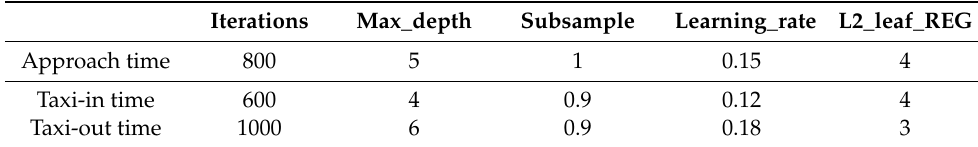
Table 5. Optimal values of key hyperparameters of the three phases